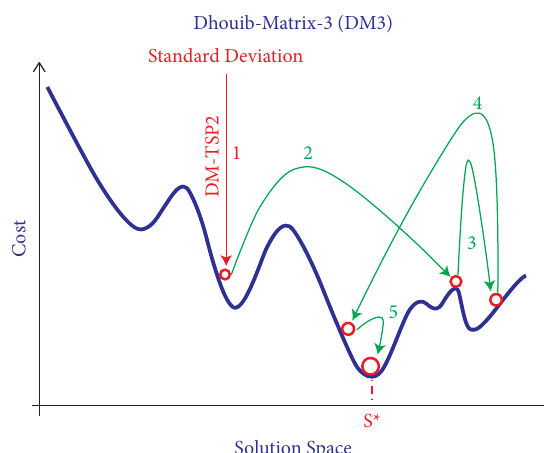
Figure 2: The exploration of the solution space through